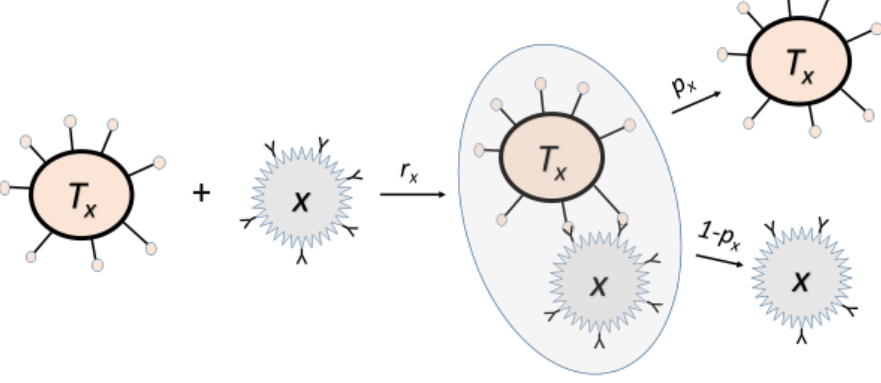
Figure 1. Naïve T-cells are activated by pathogens (including cancer cells) via dendrite cells to produce pathogen specific cytotoxic T-cells ( T x ) by detecting the pathogens ( x ). The cytotoxic T-cells are eliminated naturally or removed from the pool of effector cells, with probability 1 − p x after binding to pathogens a number of times. The pathogens are eliminated with probability p x